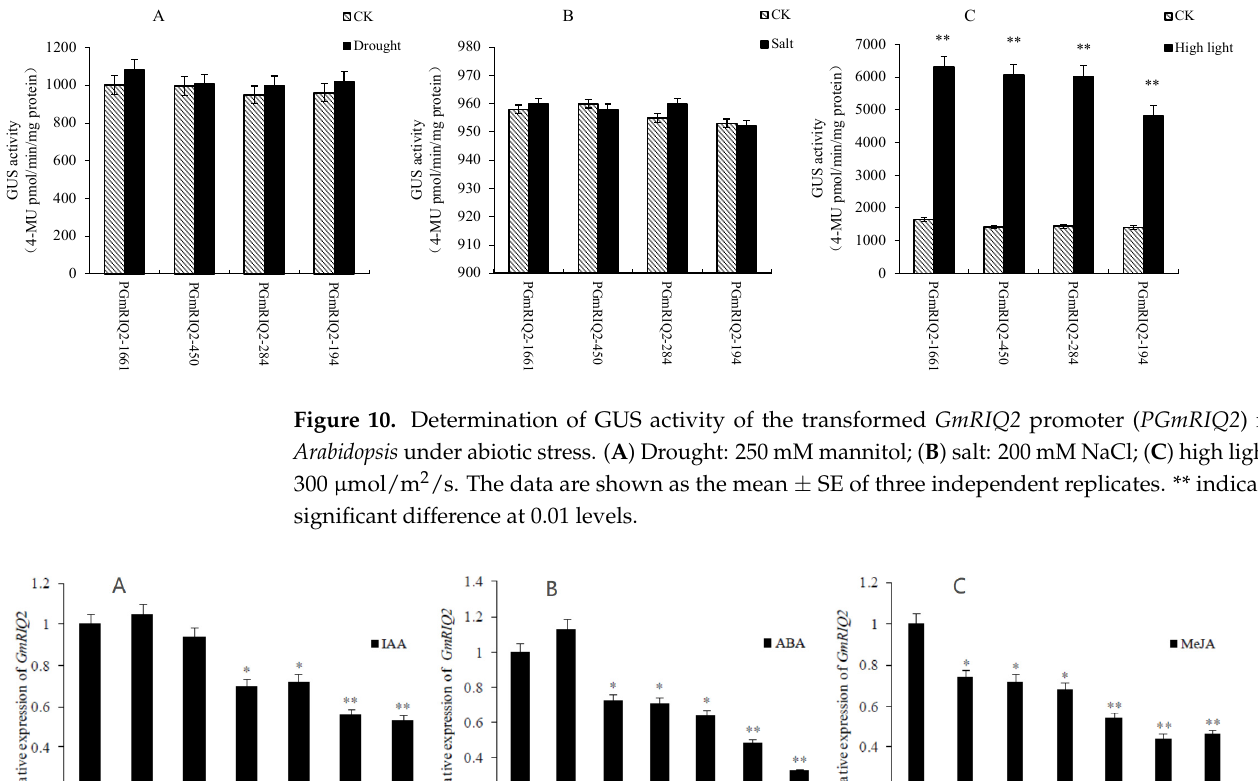
Figure 9. Hormone treatment after transformation of the GmRIQ2 gene deletion fragment promoter in Arabidopsis GUS . ( A ) IAA: 50 µ M; ( B ) ABA and ( C ) MeJA: 100 µ M. The data are shown as the mean ± SE of three independent replicates. ** indicate significant difference at 0.01 levels.